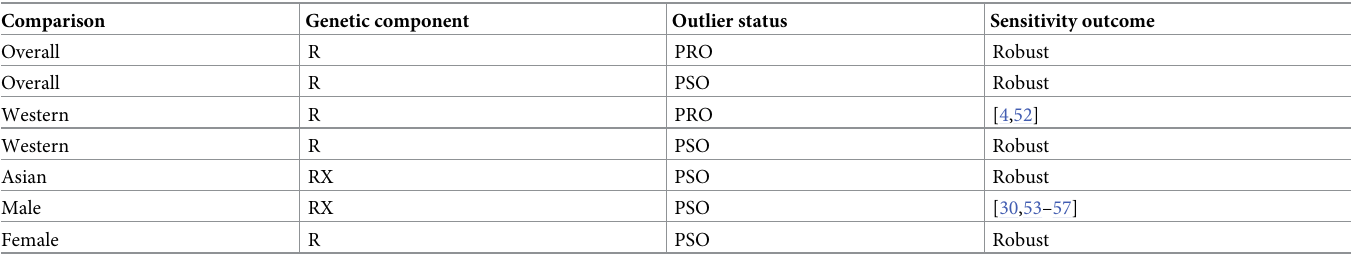
Table 5. Sensitivity analysis.